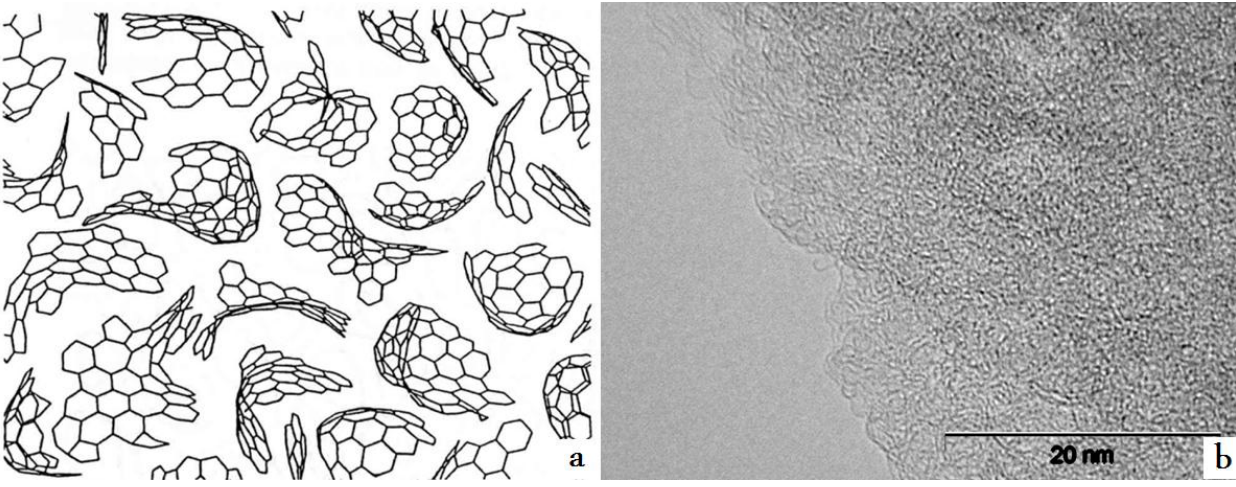
Figure 1. A structure (a) [7] and High Resolution Transmission Electron Microscope (HRTEM) picture (b) of amorphous microporous